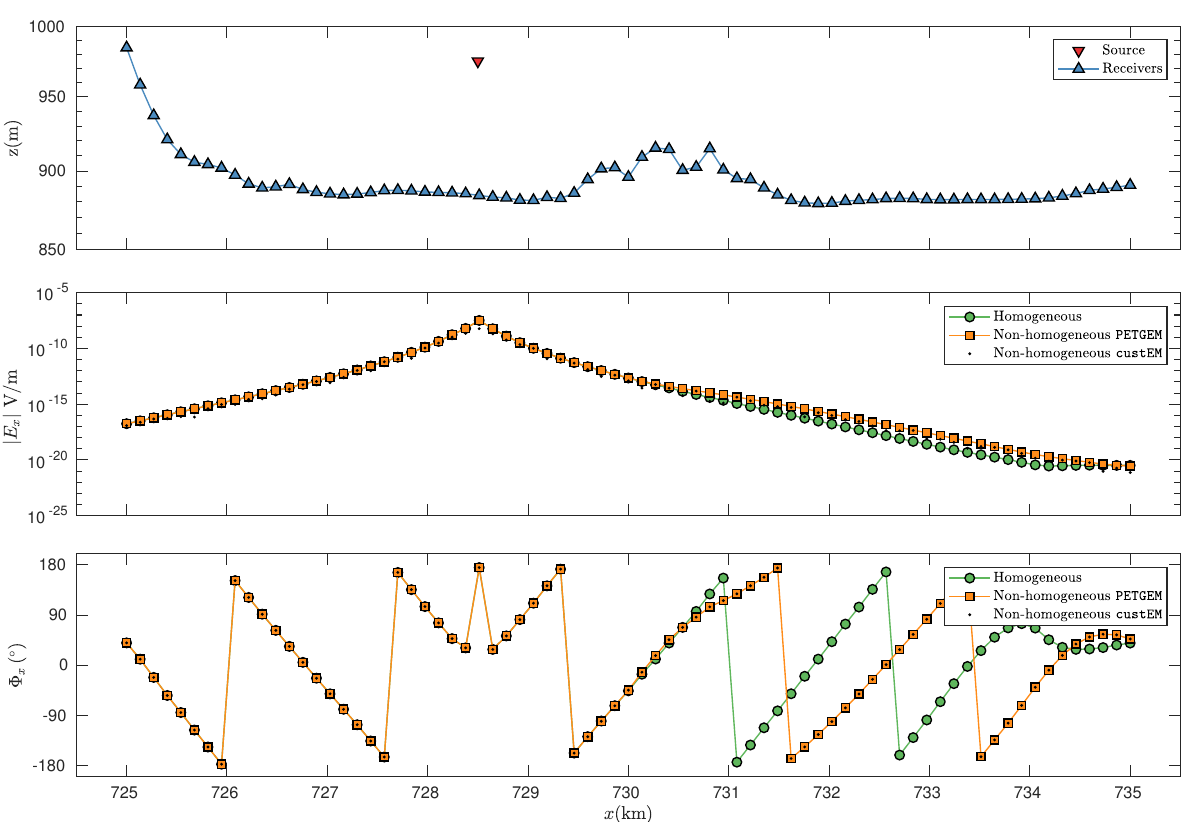
Figure 4. Electric field responses for in-line profile of the synthetic 3D-VTI-B model depicted in Figure 3. Details of the seabed profile with transmitter and receivers positions are depicted in the top row. The amplitude | E x | and phase Φ x are depicted in the middle and bottom row, respectively. Homogeneous and non-homogeneous medium are